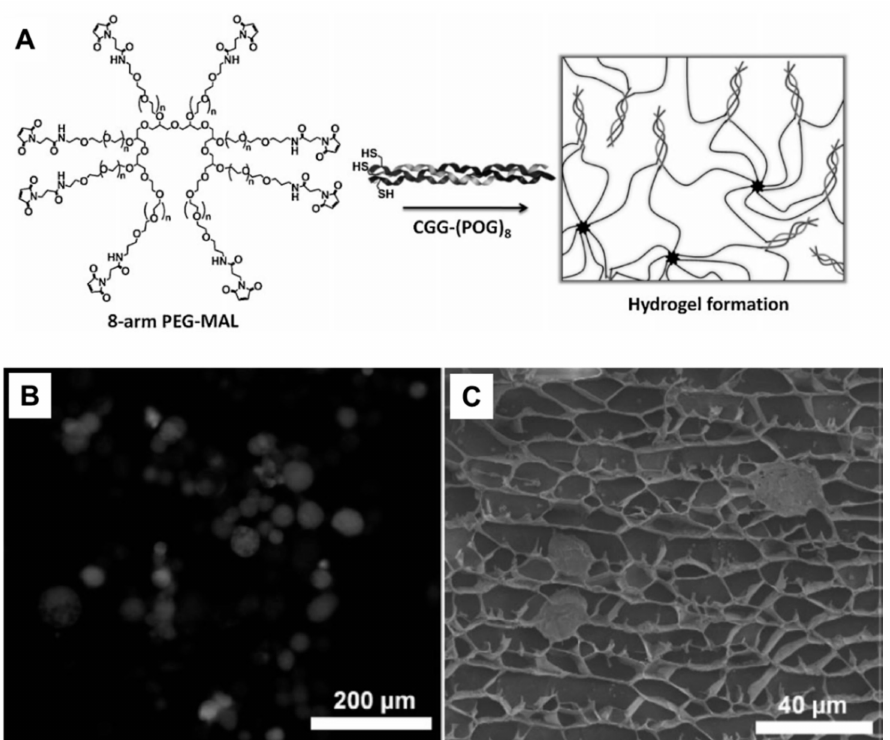
Figure 9. ( A ) Fluorescence image of hMSC cells stained with Calcein, entrapped within the non-stained gel matrix. ( B ) Cryo-SEM image of hMSC entrapped within the gel pores. ( C ) Scheme of hydrogel formation via the reaction between an 8-arm maleimide functional PEG and a collagen triple helical peptide